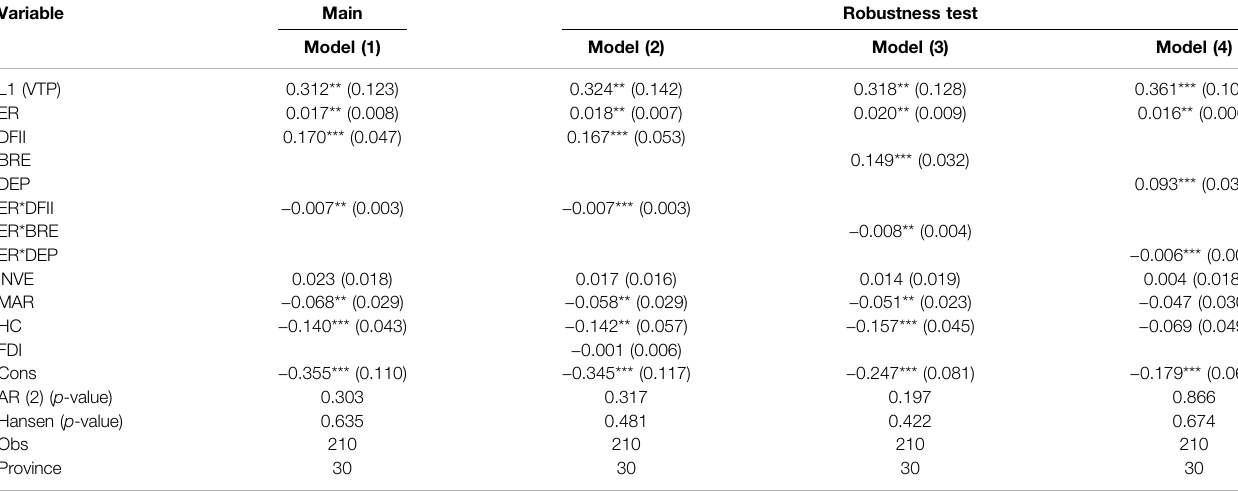
TABLE 6 | Results for the dynamic effect regression results with interactive